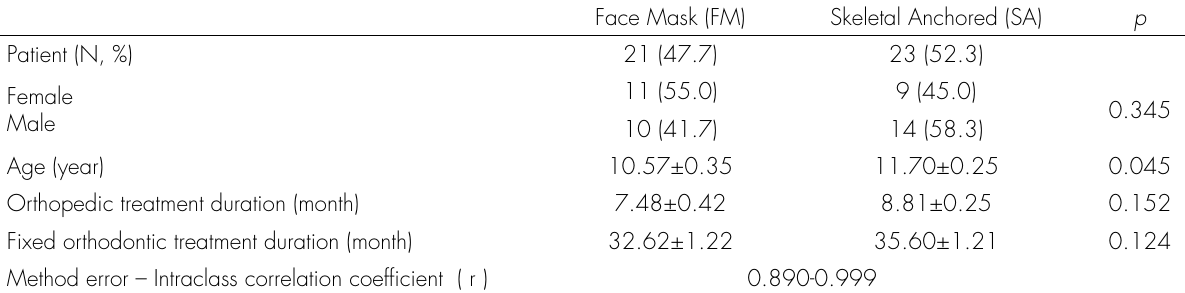
Table I. Pretreatment age, gender distribution, treatment durations and method error (N (%);